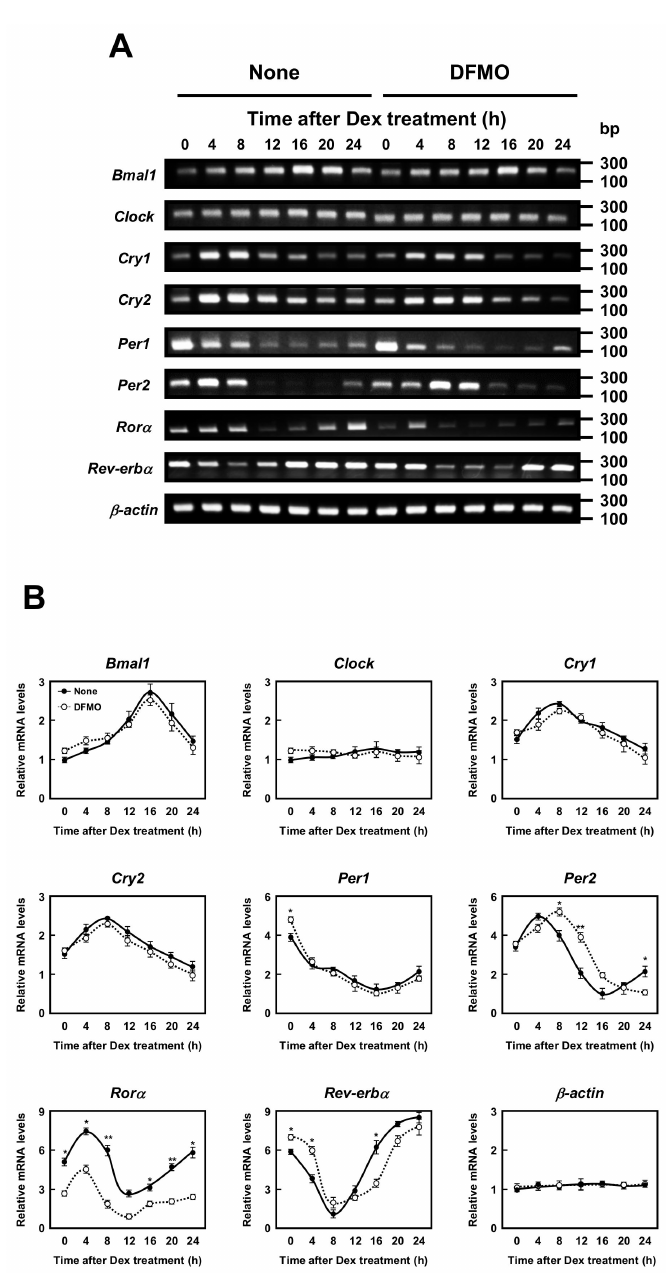
Figure 2. Measurement of mRNA level of circadian clock genes. ( A , B ) Temporal mRNA expression profiles of circadian clock genes in control and DFMO-treated NIH3T3 cells were measured by RT- PCR. The levels of circadian genes were normalized to β -actin and presented as relative expression. * p < 0.05; ** p <